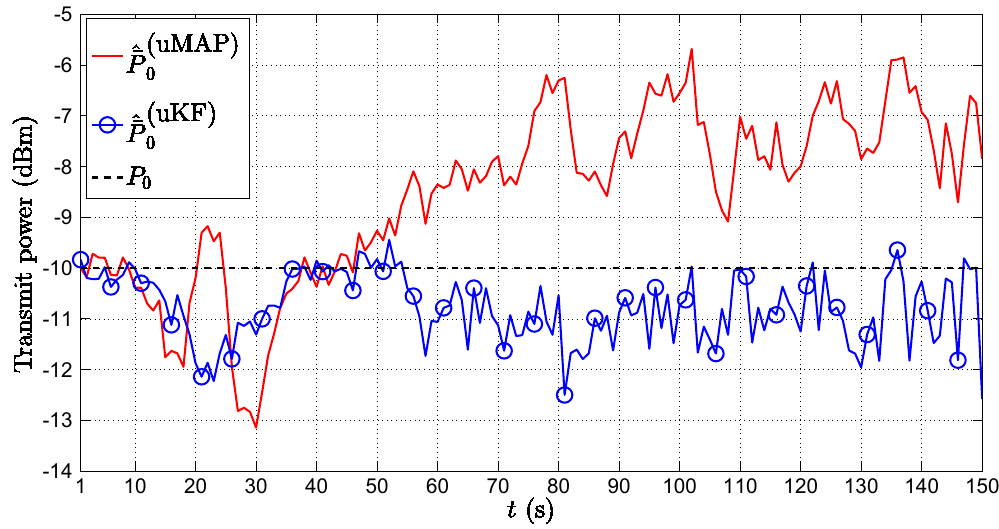
Figure 11. (cid:98) ¯ P 0 (dBm) versus t (s) comparison in the second scenario, when N = 2, (cid:107) v a (cid:107) = 0 m/s, = 9 dB, σ m = 4 π σ n rad, γ = 3, γ i ∼ U [ 2.7,3.3 ] , τ = 5 m, P 0 = − 10 dBm, q = 2.5 × 10 − 3 m 2 /s 3 , 180 i i M c =